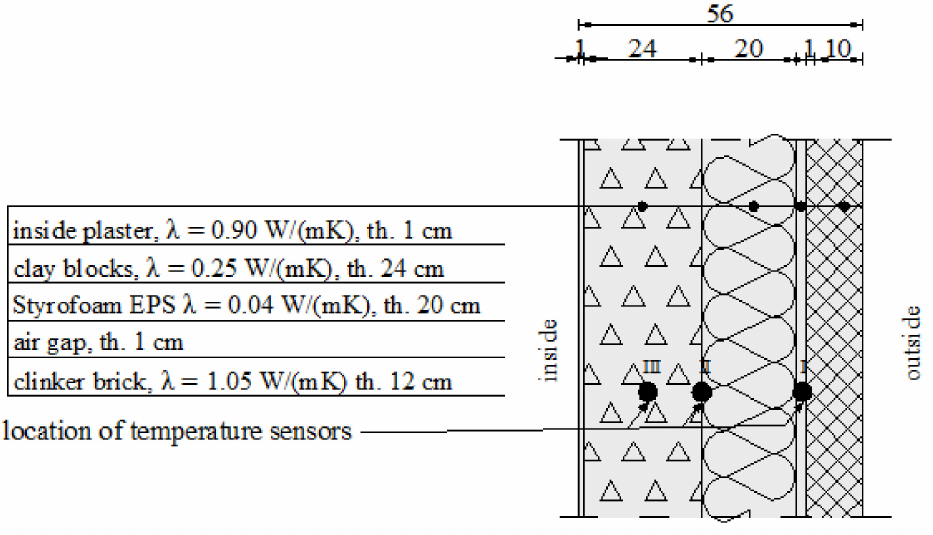
Figure 1. Three-layer wall cross